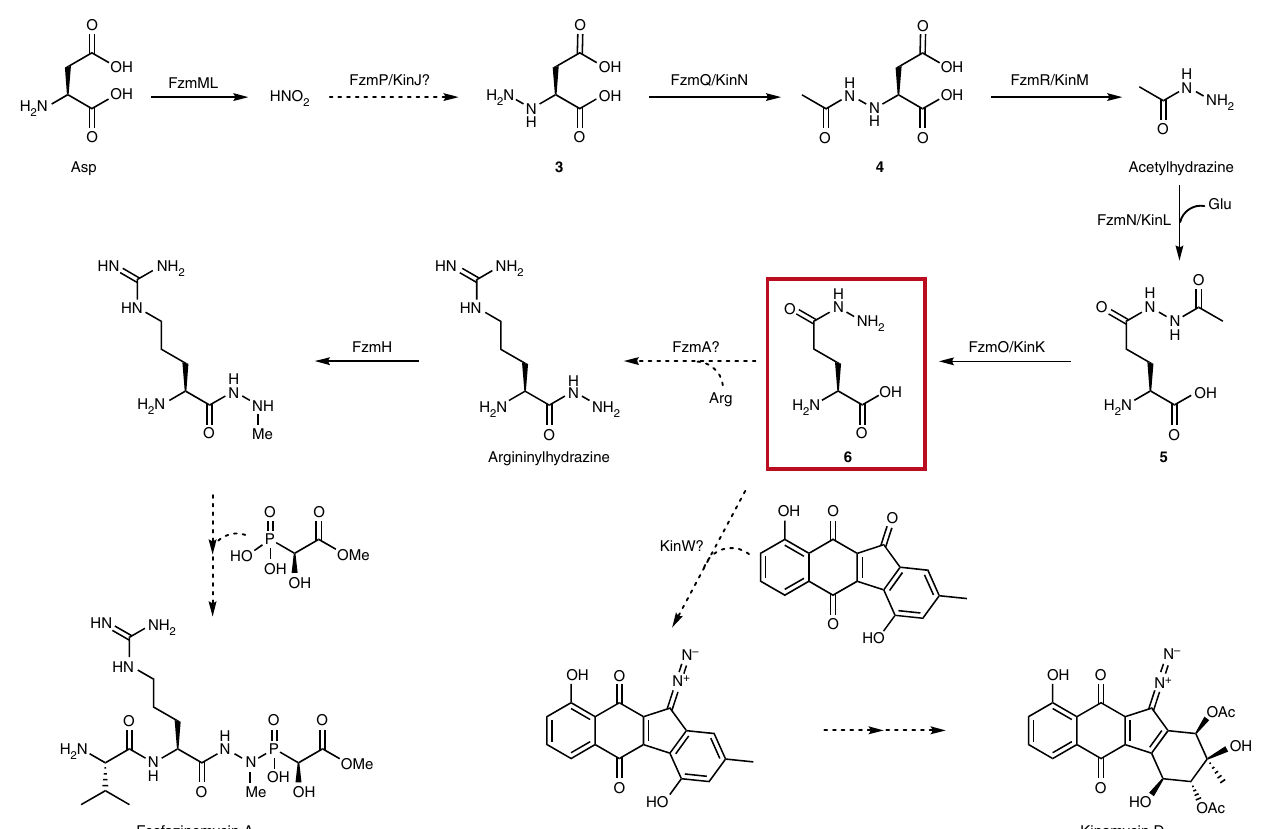
Fig. 6 Proposed biosynthetic pathways for fosfazinomycin and kinamycin. Solid arrows indicate steps that have been reconstituted. Dashed lines indicate putative steps. Compound ( 6 ) (highlighted by the red box) acts as the carrier of the hydrazine synthon and is the branch point where the biosyntheses of fosfazinomycin and kinamycin